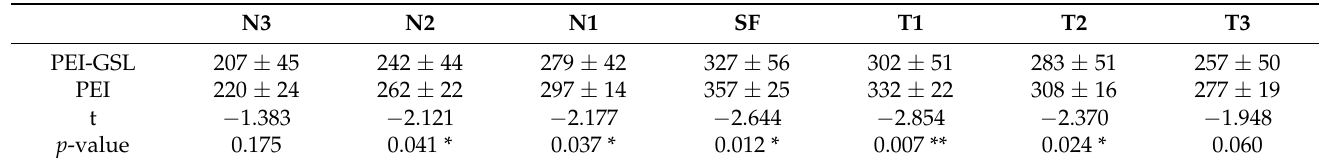
Table 6. Comparisons of preoperative CT between PEI-GSL and PEI groups.